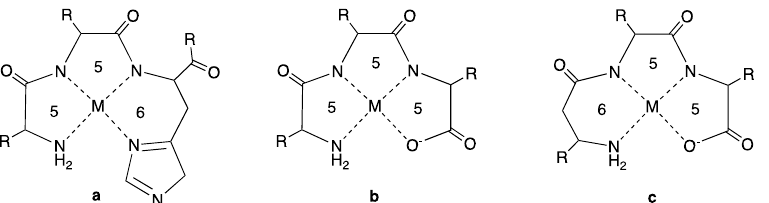
Figure 1. ( a ) ATCUN-motif, when M = Ni, Cu. ( b ) Coordination motifs for metal peptide complexes, M = Pd, Ni, or Cu. ( c ) Coordination motifs for metal peptide complexes with κ 4 [6,5,5] chelation.